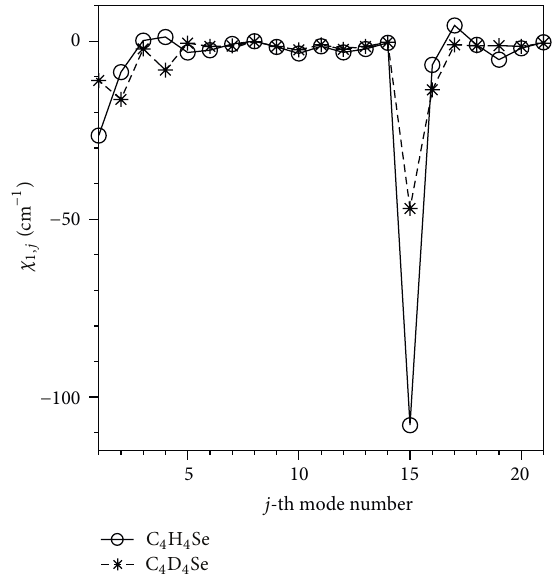
Figure 6: B3LYP/6-311G ∗∗ anharmonic IR (bottom) and Raman (top) spectra of C 4 D 4 Se in the 500–1500 cm −1 wavenumber range. Lorentz line shapes with half-width of 10cm −1 were